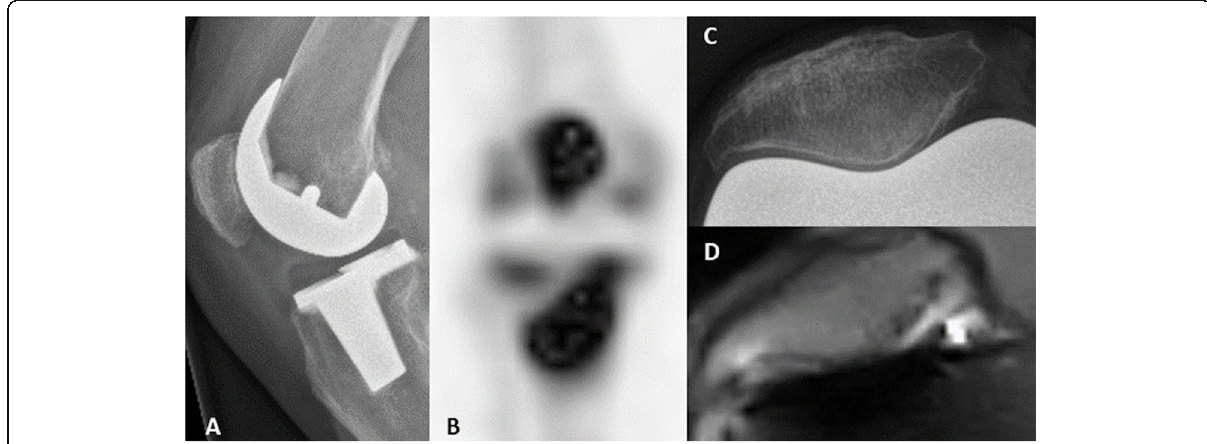
Fig. 6 Patellofemoral arthrosis. The conventional radiograph ( a ) of patient 8, together with the bone scintigraphy ( b ), the additional patellofemoral radiograph ( c ) and the low-field MRI ( d ). Except for the conventional radiographs ( a ), all other images b - d ) show patellofemoral arthrosis